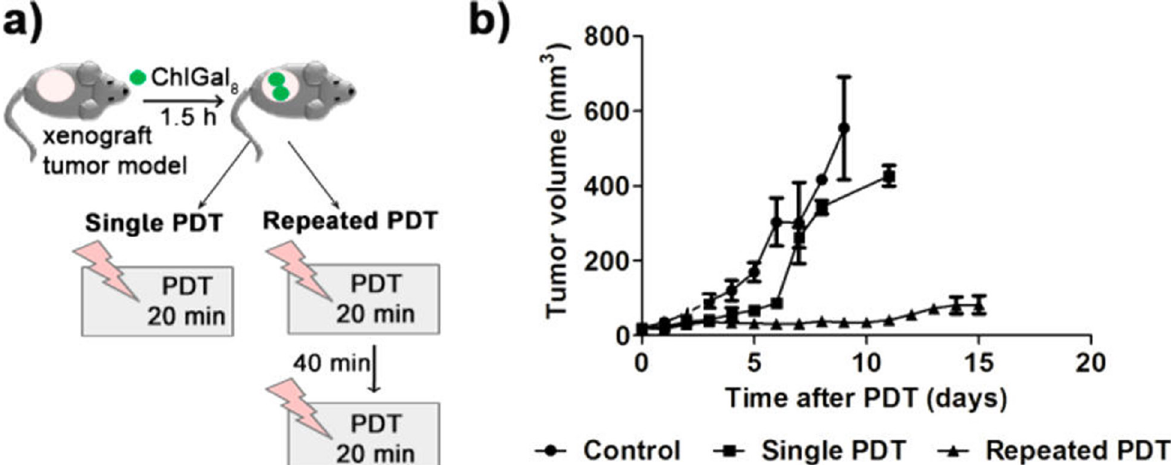
Figure 39 - Repeated PDT treatment with ChlGal8 improves the in vivo photodynamic efficacy against HT-1376 tumors inoculated in nude mice. ( a ) Schematic illustration of single and repeated PDT experiments performed in vivo with Chl-Gal volumes in control mice and mice treated with single and repeated PDT at days 1−15 after treatment. Values are means ± standard error of the mean (n = 6 mice per group). Reproduced from Pereira et al. 2016a with permission of The American Chemical Society.